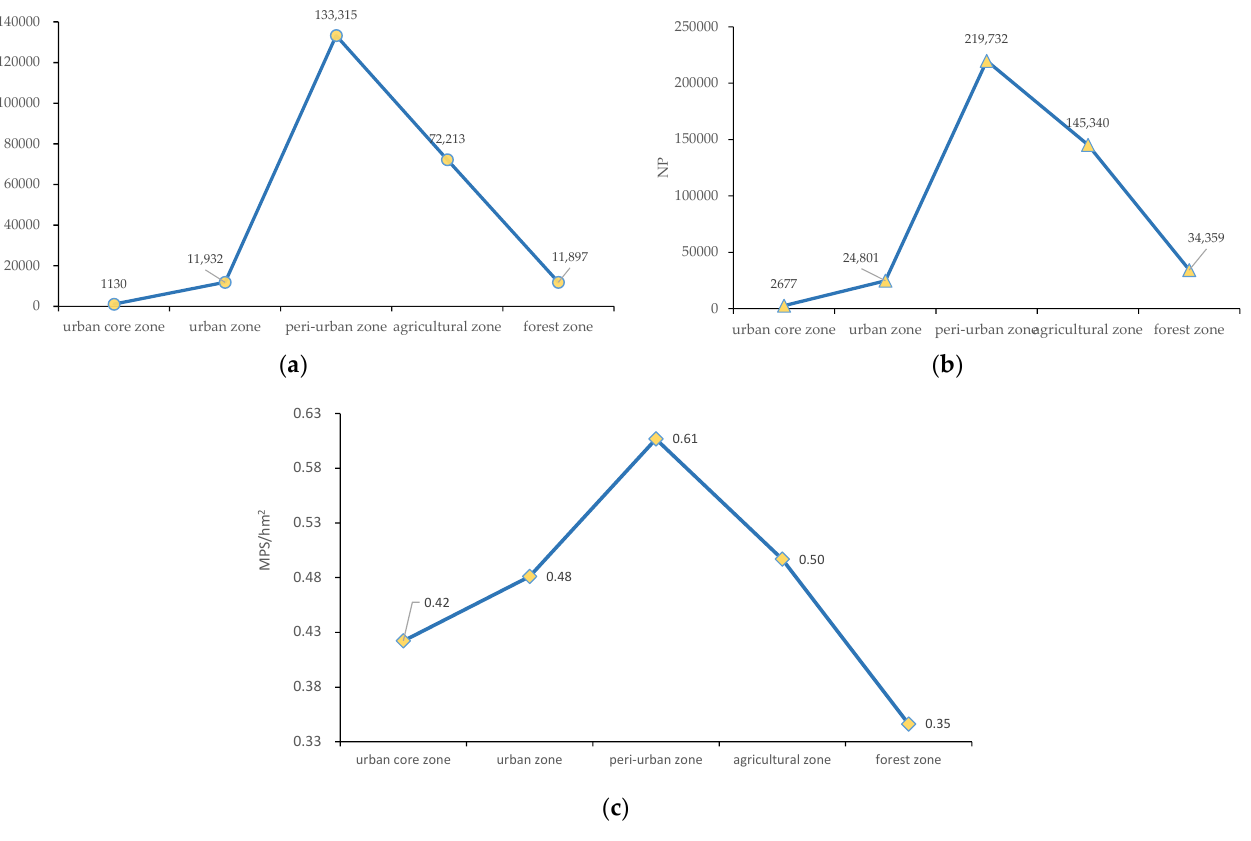
Figure 5. ( a ) Total area of pond landscape patches (CA); ( b ) number of patches (NP) and ( c ) mean patch area (MPS) along an urban-rural gradient in the PRD.